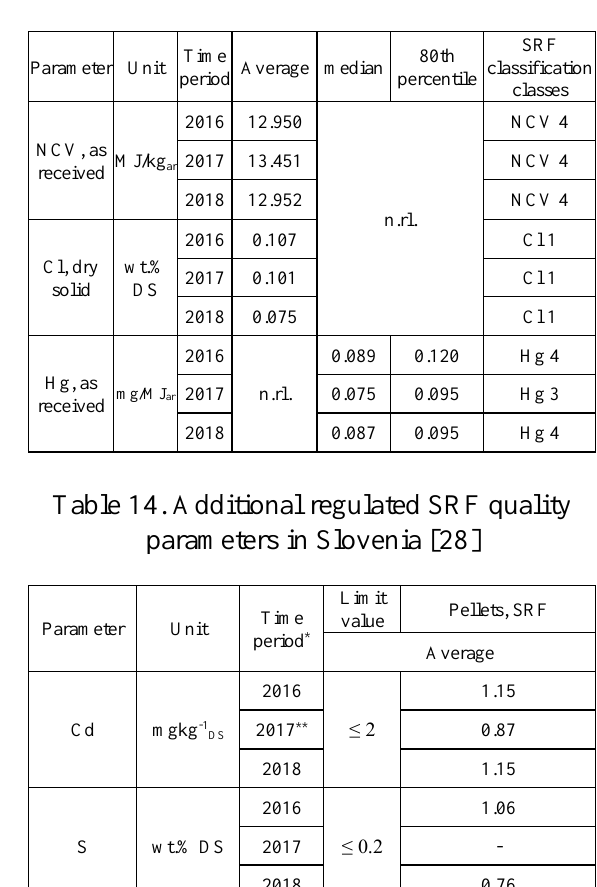
Table 13. Specification of pellets as a SRF: determination of classification classes [28]